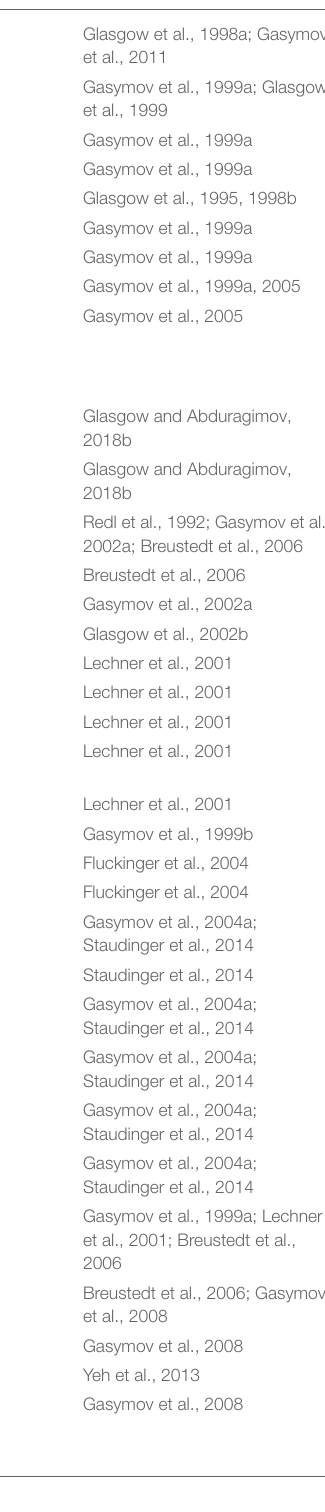
TABLE 3 | Interacting molecules (ligands) native and non-native of tear lipocalin with binding constants. Ligand Kd ( µ M) and/or special